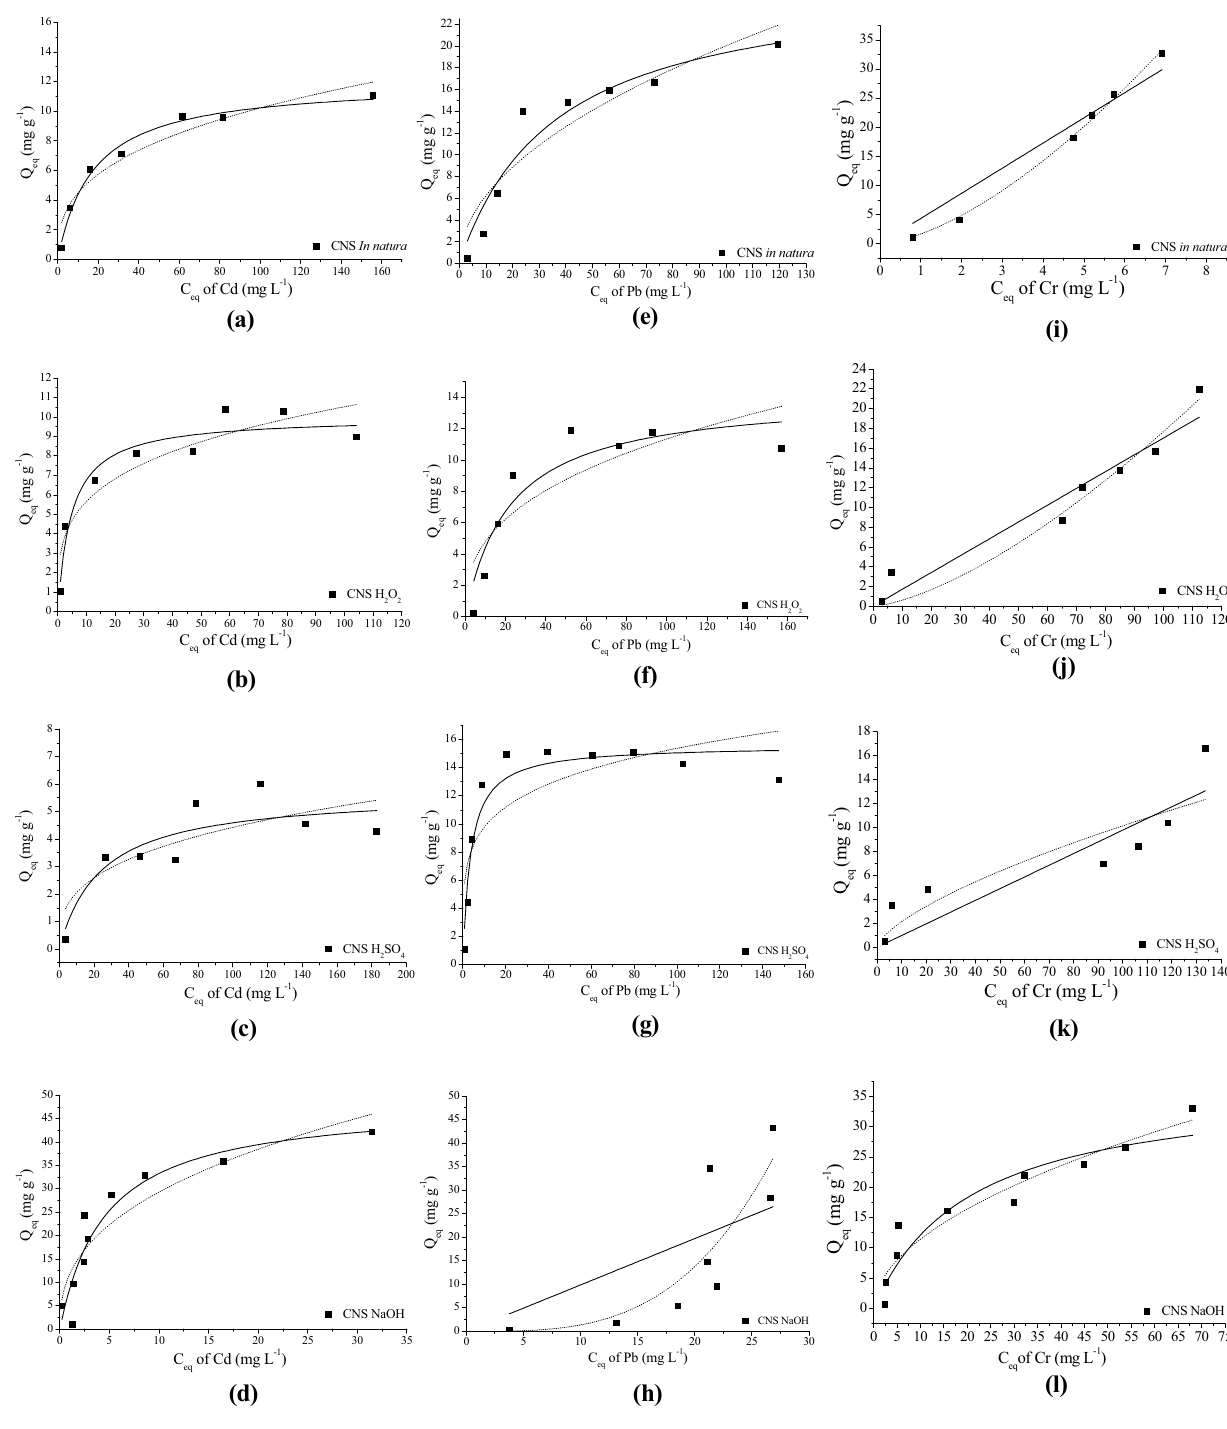
Fig. 11 Langmuir and Freundlich isotherms for sorption of Cd 2+ ( a – d ), Pb 2+ ( e – h ) and Cr 3+ ( i – l ), respectively, by the CNS in natura (Coelho et al. 2014) and modified with H 2 O 2 , H 2 SO 4 and NaOH. Source : the